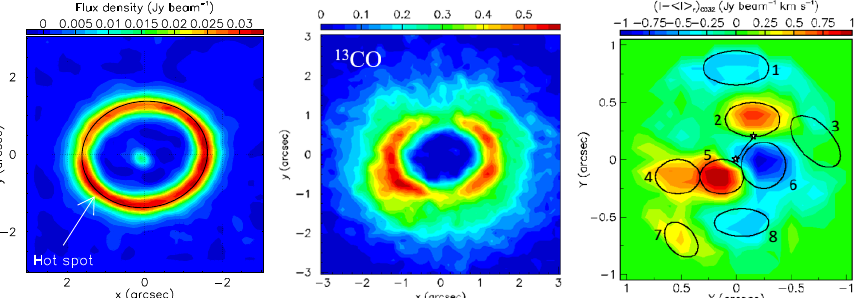
Fig. 5 GG Tau A. Left: intensity map of the dust ring. Centre: 13 CO gas distribution around the cavity. Right: emission in the cavity revealing the presence of gas